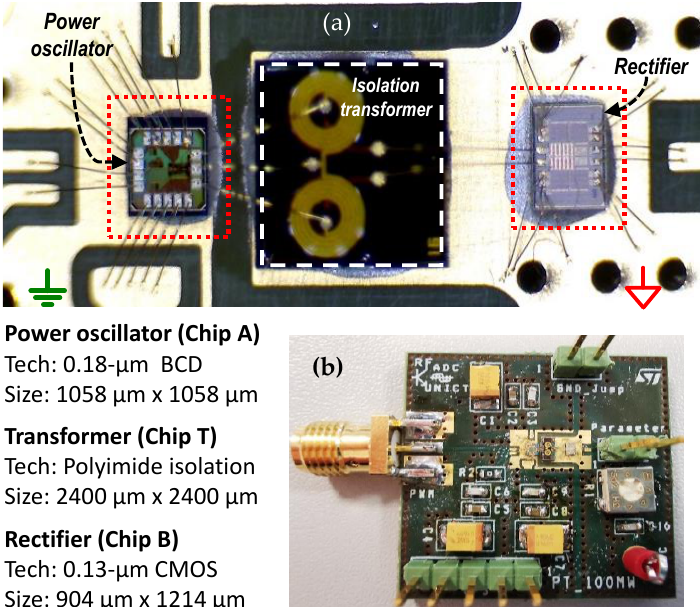
Figure 11. ( a ) Isolated DC-DC converter assembled chip on board; ( b ) testing PCB.